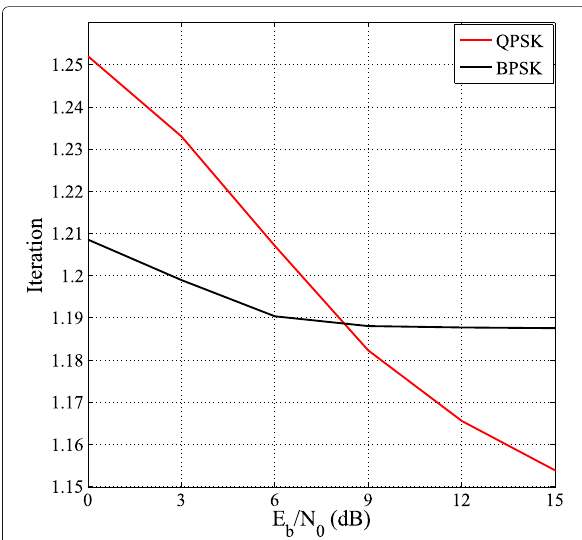
Fig. 4 The average number of iterations versus E b / N 0 of EM detector for MM-OFDM-IM ( n = 8, BPSK/QPSK). Figure 4 shows the average number of iterations versus E b / N 0 of EM detector with BPSK and QPSK modulation for